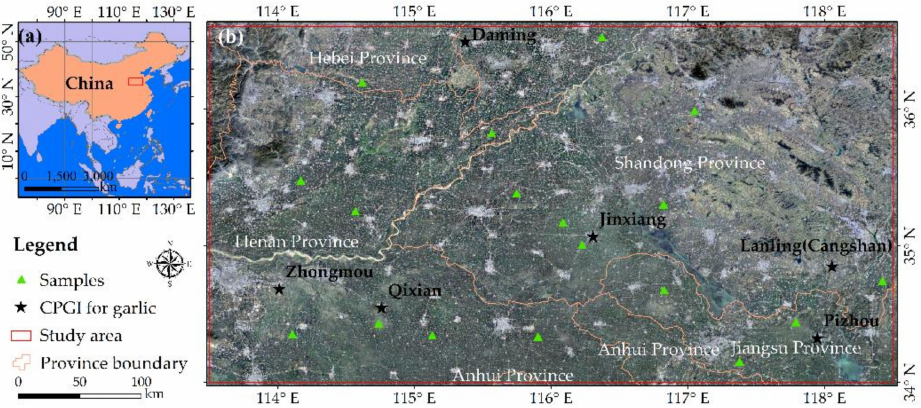
Figure 1. ( a ) Location of the study area in China and ( b ) distribution of validation samples and the China protected geographical indication products (CPGI) for